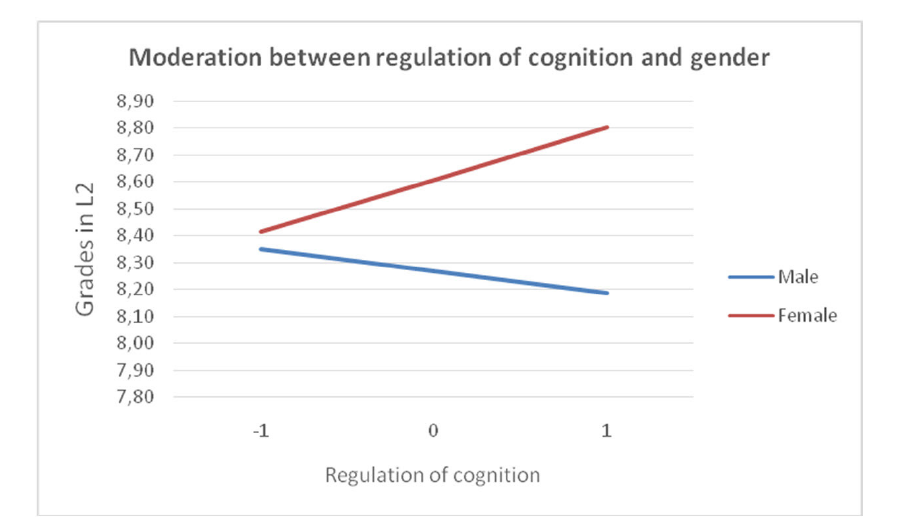
Chart 1. Moderation between regulation of cognition and gender based on the grade in L2